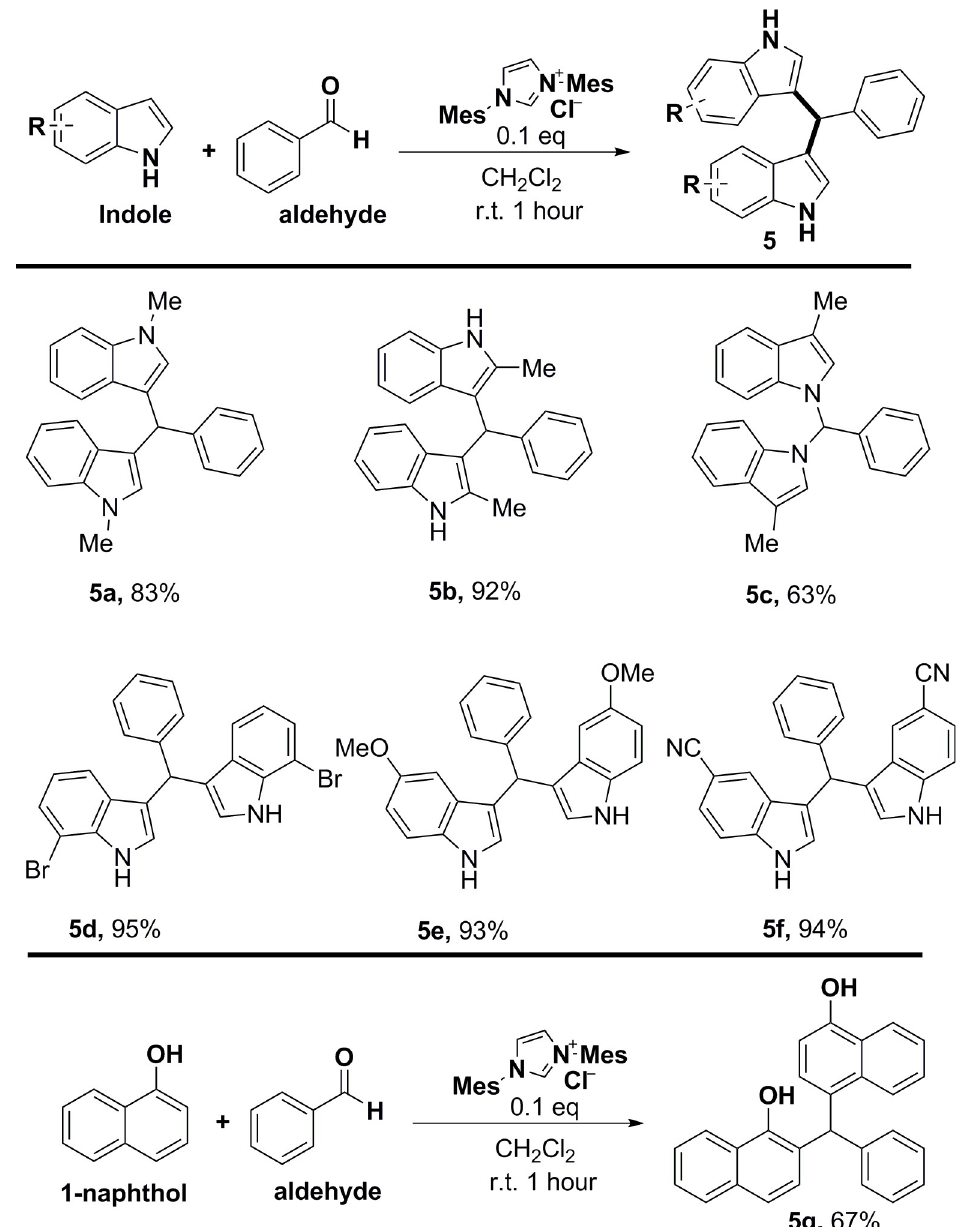
Fig 5. Scope of indoles and naphthols a, b